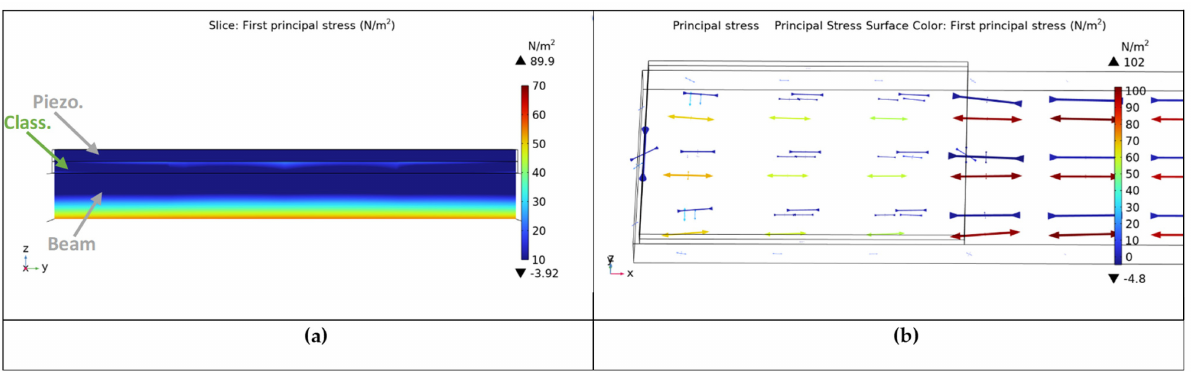
Figure 4. Stresses for the auxetic layer. ( a ) cross-section and ( b ) principal stresses.